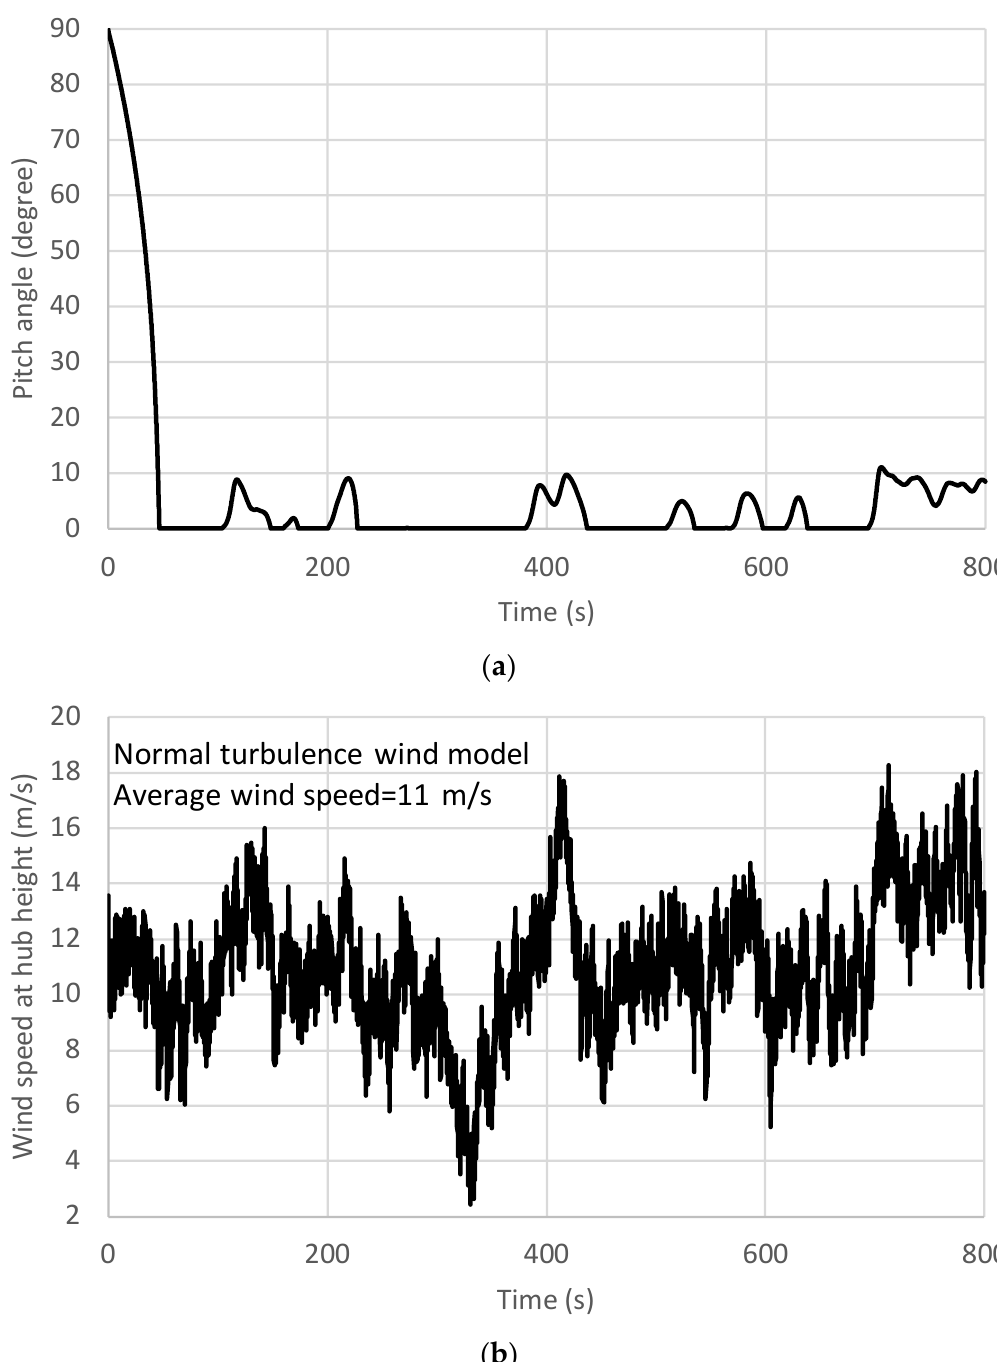
Figure 4. The pitch angle of the three blades and the X-direction turbulence wind speed at the hub under DLC 1.1 with the average speed of 11 m/s using the FAST simulation. ( a ) Pitch angle of the three blades; ( b ) X-direction turbulence wind speed.